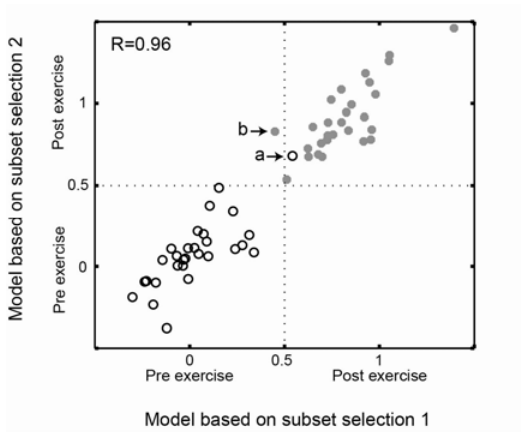
Figure 3. Comparison of prediction similarity for models based on the two subset selection strategies. The prediction values from the two models show a strong correlation, R=0.96 (Pearson correlation). This implies that both models did find the same or a similar metabolic pattern, differentiating the two study groups. All samples except one were classified equally by the two different models in terms of class belonging. One of the samples in the pre- exercise group were wrongly predicted by both models (marked a), while one of the post- exercise samples were predicted correctly by the subset selection 2, but wrongly by the subset selection 1(marked